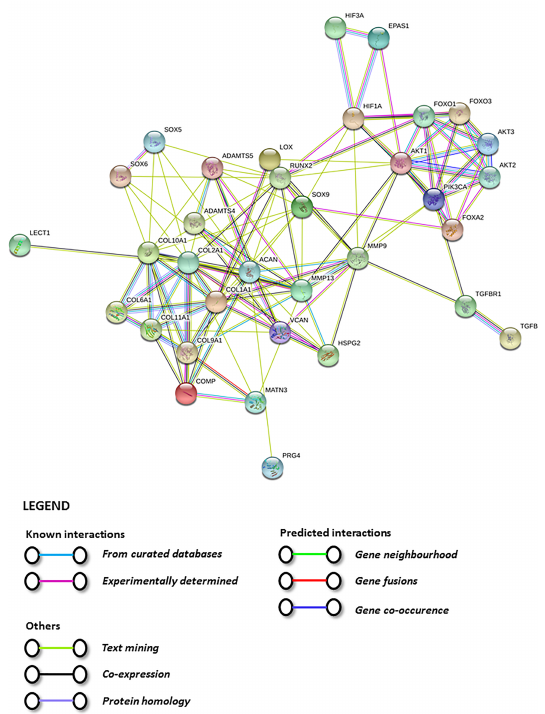
Figure 4. STRING database analysis based upon genes and proteins under the influence of physioxia and chondrogenesis, which describes the interactions based on the database analysis between proteins.